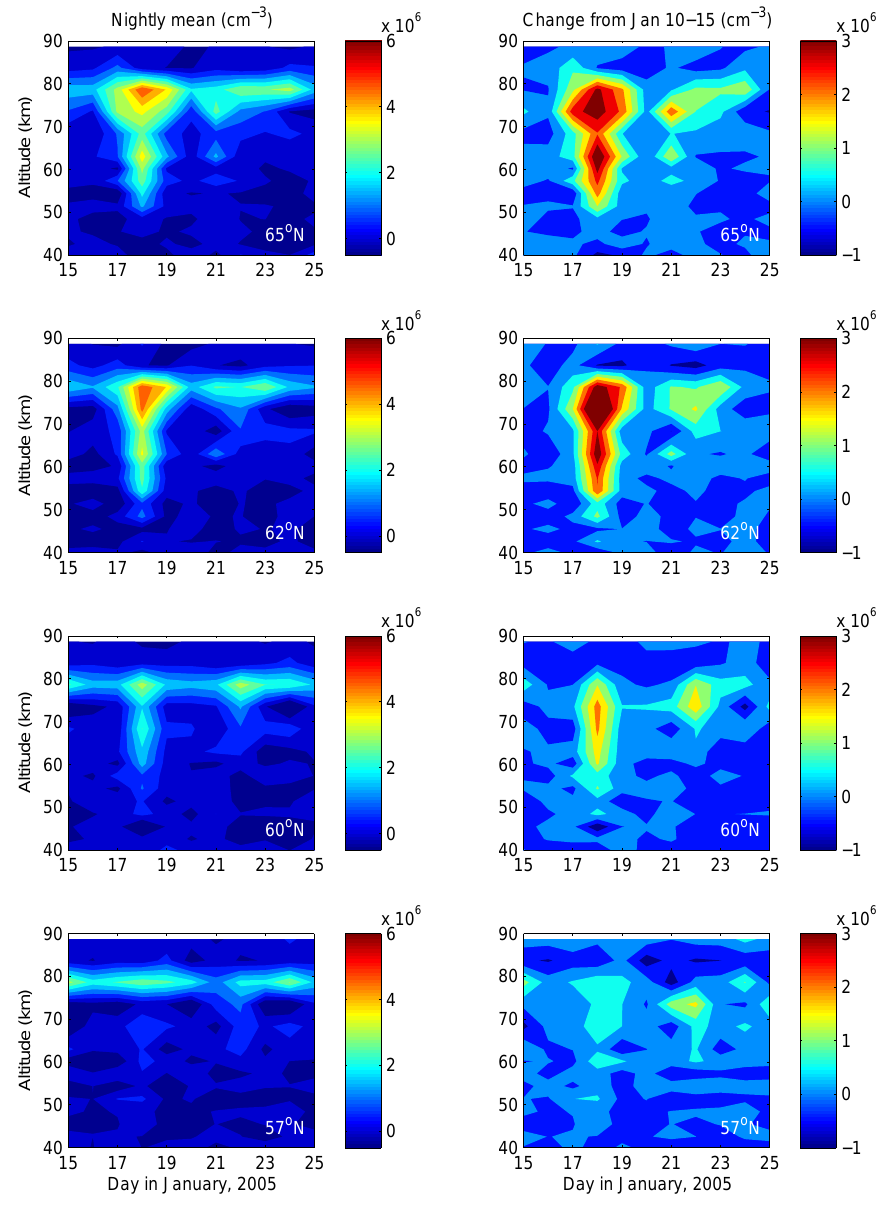
Fig. 3. Left panels: MLS/Aura observations of night-time OH at selected magnetic latitudes. The data has been averaged to 2 ◦ -wide latitude bins at 19:00–05:00UT for each day. The local time of the observations ranges between 02:30 and 03:00. Right panels: the change from the average of values observed on 10–15